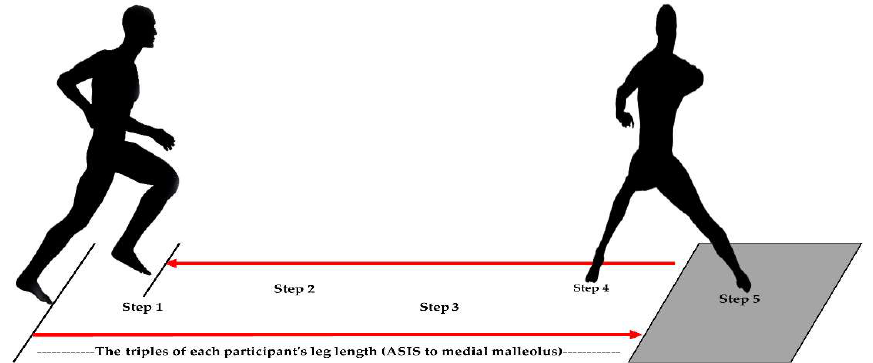
Figure 2. The shuttle run task utilized in this study [5,19]. The participants made a 180° directional change at the transition and came back to the starting position. They were instructed to perform the task as soon as possible.